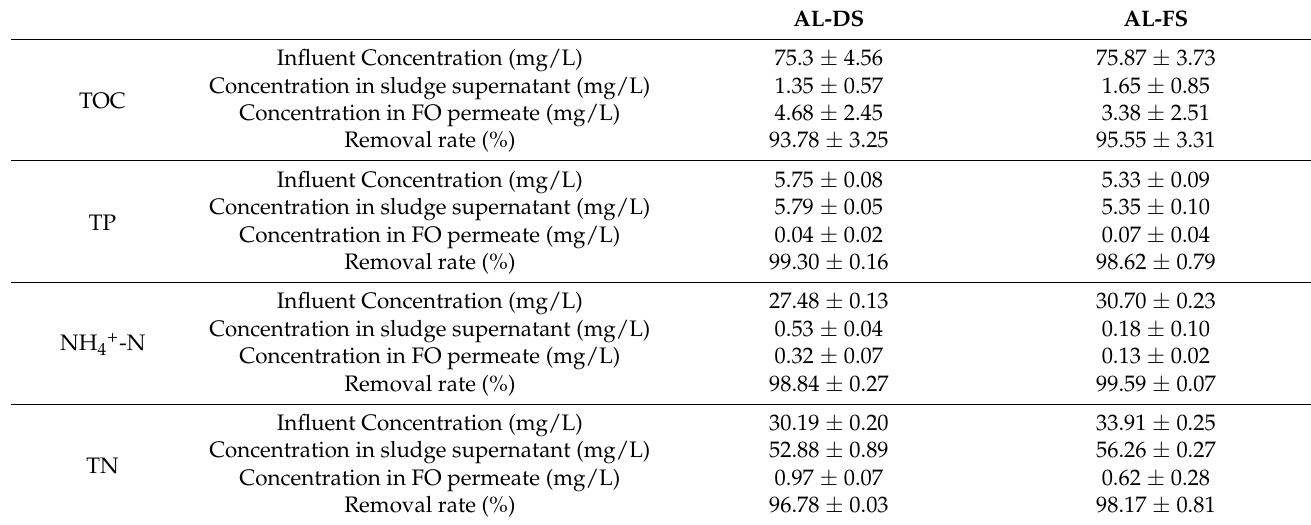
Table 3. TOC, TP, NH 4+ -N, and TN concentrations in the influent sludge supernatant and FO permeate and their removal rate by PRO-MBR process a